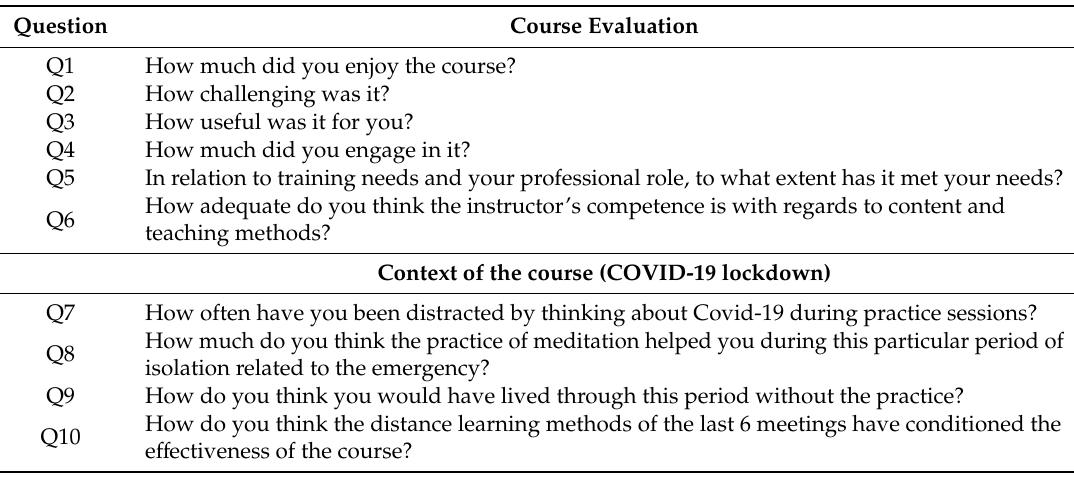
Table 1. The questions for the teachers’ evaluation of the